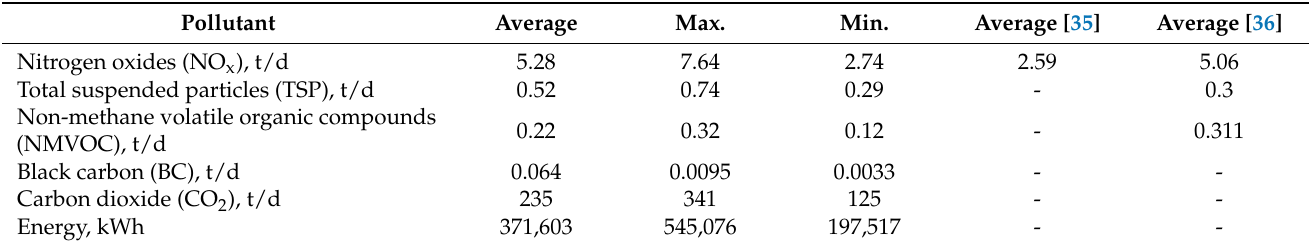
Table 2. Average and maximum emissions in Klaipeda port.